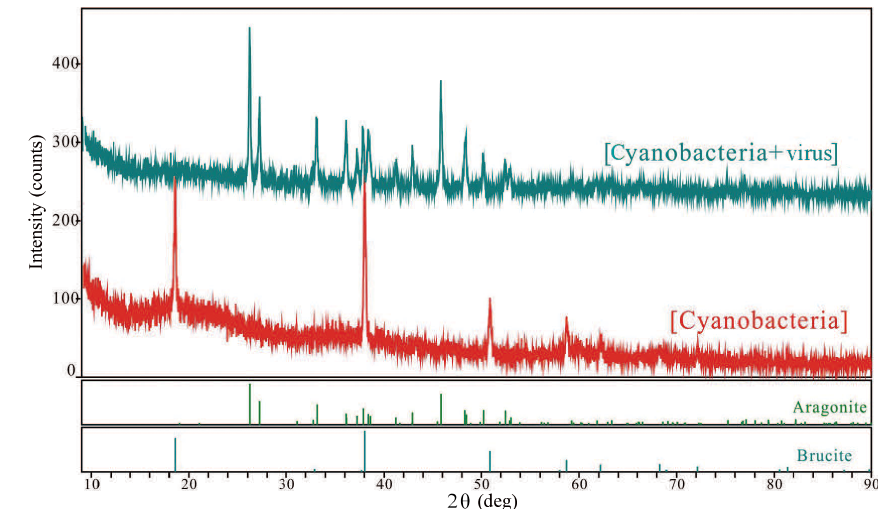
Figure 6. Typical X-ray diffraction patterns collected for each polymorph that formed in this study. Table 2. Saturation indices calculated from culture system by